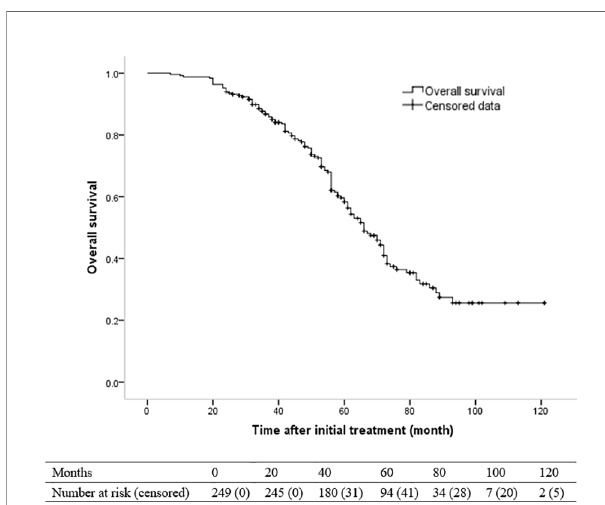
without transarterial chemoembolization (median OS, 66 months).